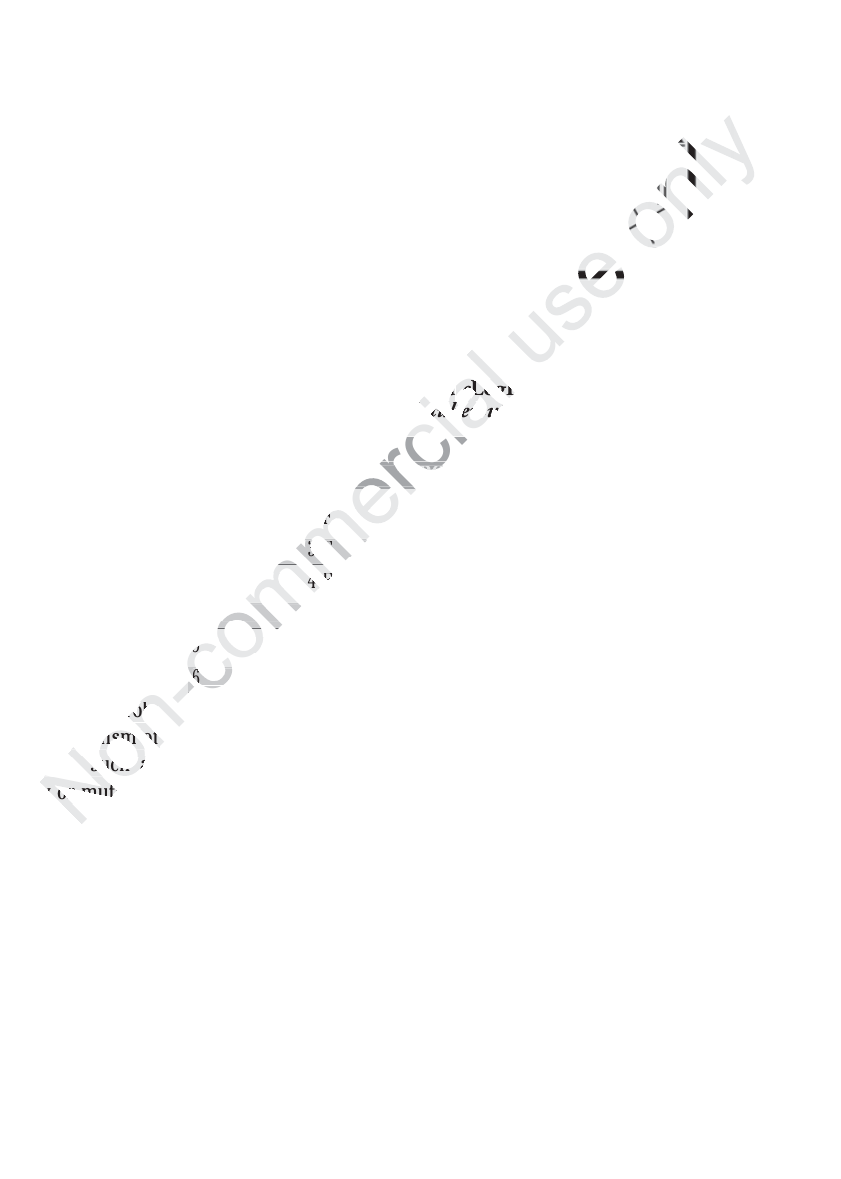
Table 1. In vitro activity and c LogP measurements of compounds 1-23 against suscepti- ble and INH-resistant M. tuberculosis strains.